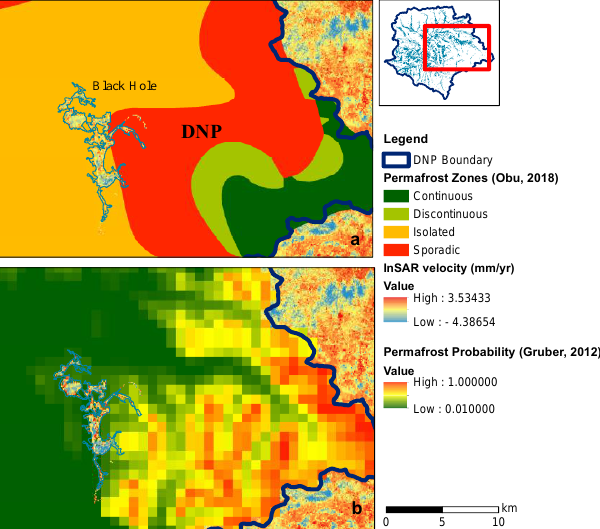
Figure 12. Maps of the study area of Black Hole with: ( a ) the permafrost zoning [15] and ( b ) the permafrost probability index by Gruber, 2012 [9]. The red box of the high-right map of the DNP represents the area in ( a , b ).